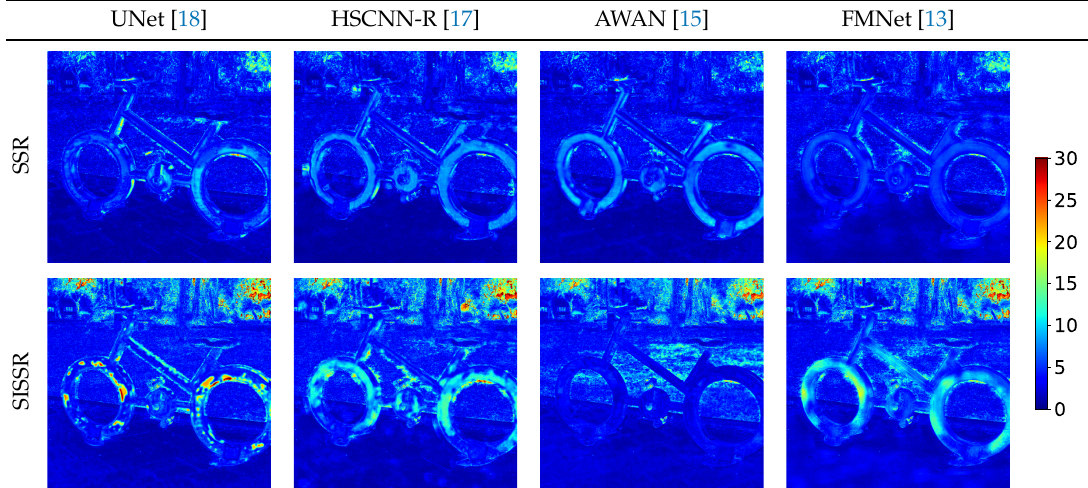
Figure 5. Qualitative visualization of the achieved reconstruction quality. For each method, the prediction error (MRAE) is shown per